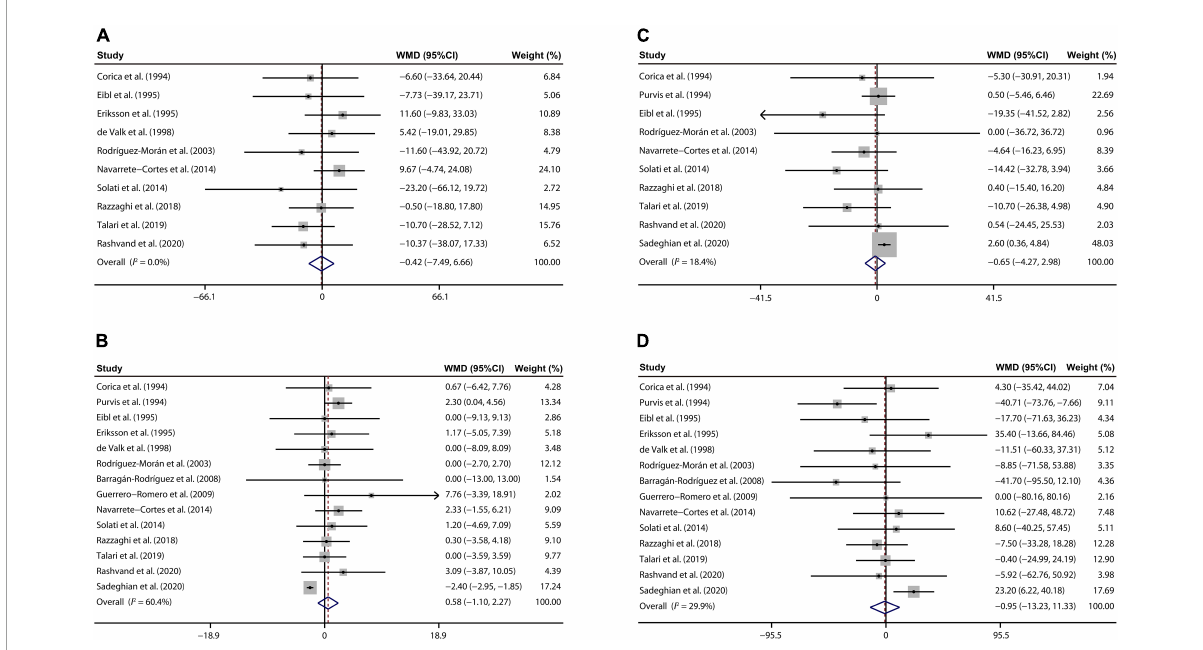
FIGURE3 Forest plots for the effects of magnesium supplementation on TC (A) , HDL-C (B) , LDL-C (C) , and TG (D) compared to controls in pooled analysis. For each study, the solid black circles represent the point estimate of the intervention effect. The horizontal line joins the lower and upper limits of the 95% CI of this effect. The open diamonds represent the overall WMD determined with a random-effect model. HDL-C, high-density lipoprotein cholesterol; LDL-C, low-density lipoprotein cholesterol; TC, total cholesterol; TG, total triglyceride; WMD, weighted mean